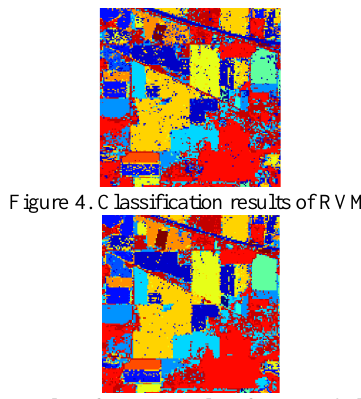
Figure 5. Classification results of proposed algorithm